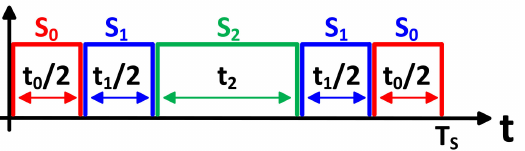
Figure 3. The allocation of the switching period between the associated switching vectors.